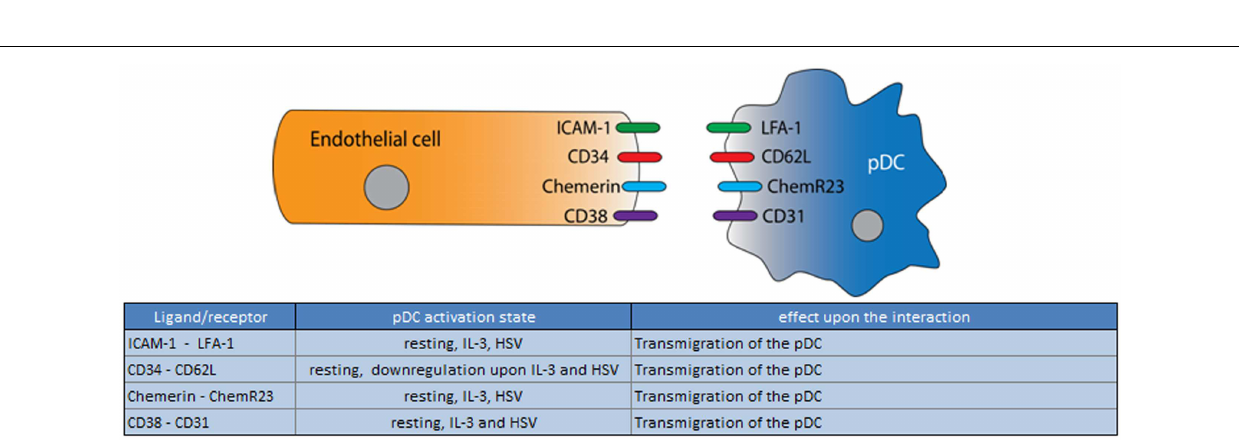
FIGURE 2 | Ligand/receptor paring of a pDC with an endothelial cell and the maturation state/activation stimuli associated with ligand or receptor expression on the pDC surface .